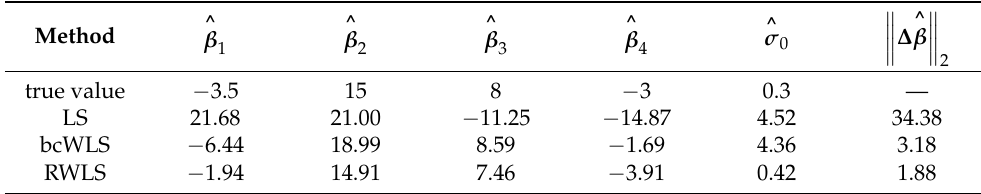
Table 6. Parameter estimation and